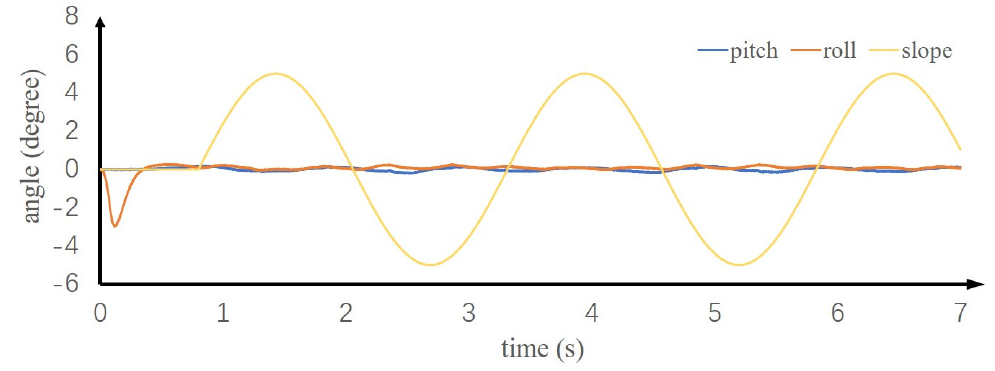
slope; ( d ) walking down slope. Sensors 2020 , 20 , x FOR PEER REVIEW